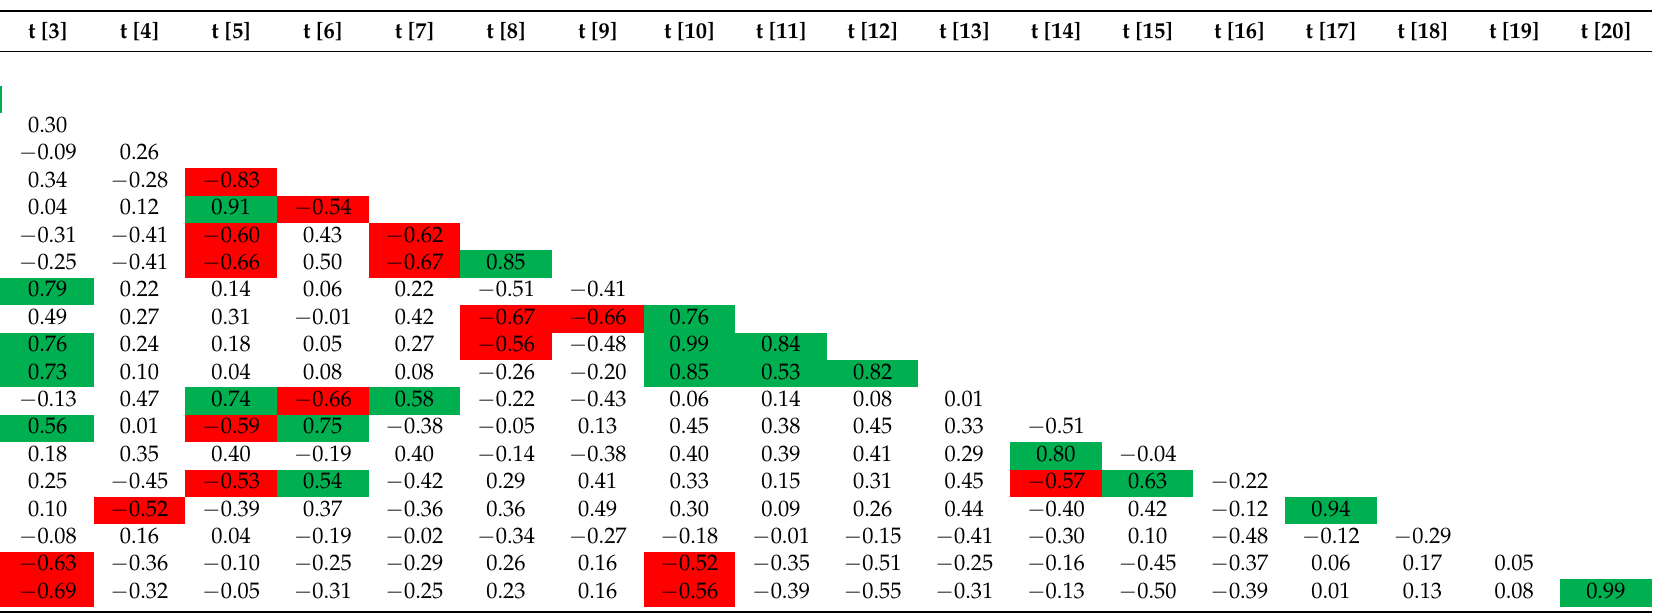
Table 2. Correlation coefficient between observed traits in drought